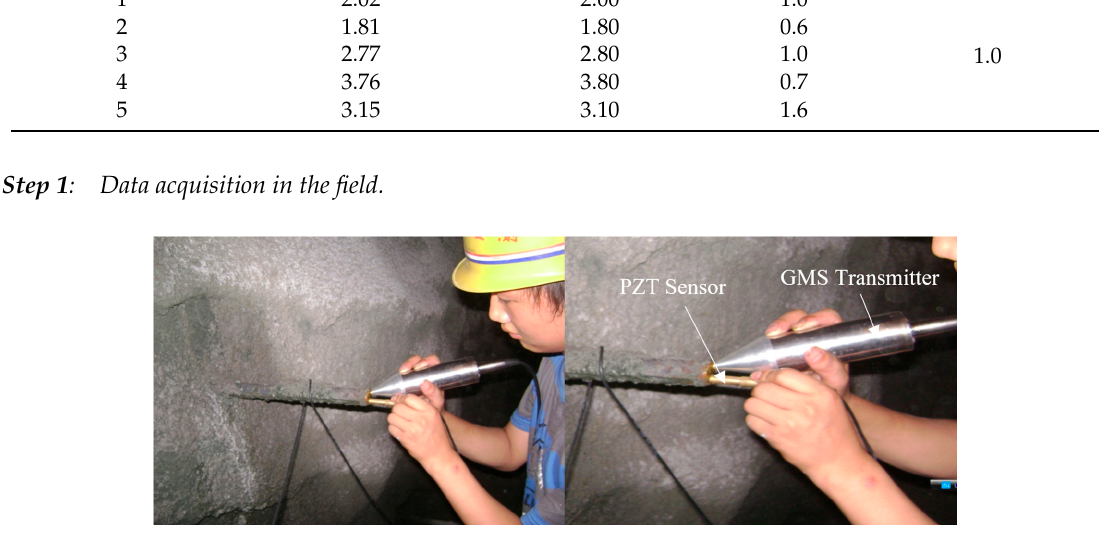
Table 2. The results for five of the chosen rock bolts at Yangqu Hydropower Station.